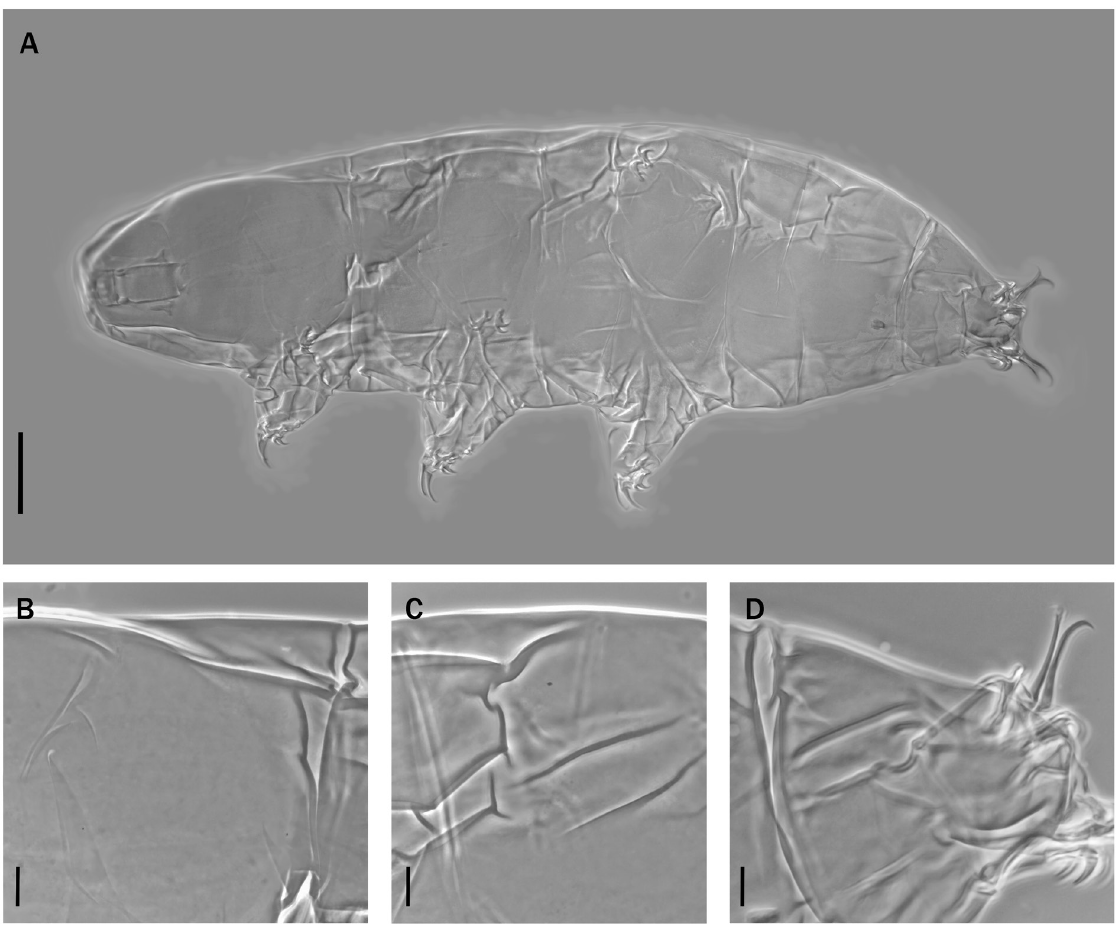
Fig. 20. Milnesium quiranae sp. nov., holotype, ♀ (slide No. MCNS Tar.000024-3). A . Habitus. B . Smooth cuticle at the level of legs I. C . Smooth cuticle between legs III and IV. D . Smooth cuticle of the caudal end of the body. Scale bars: A = 50 µm; B–D = 10